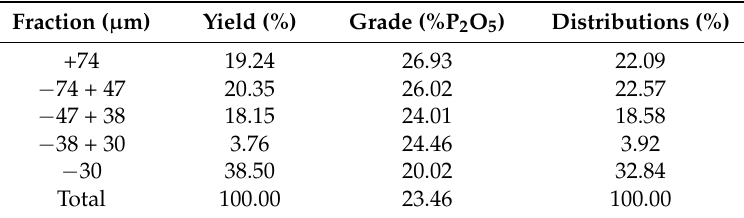
Table 3. The size distribution and chemical analysis of the phosphate ore.